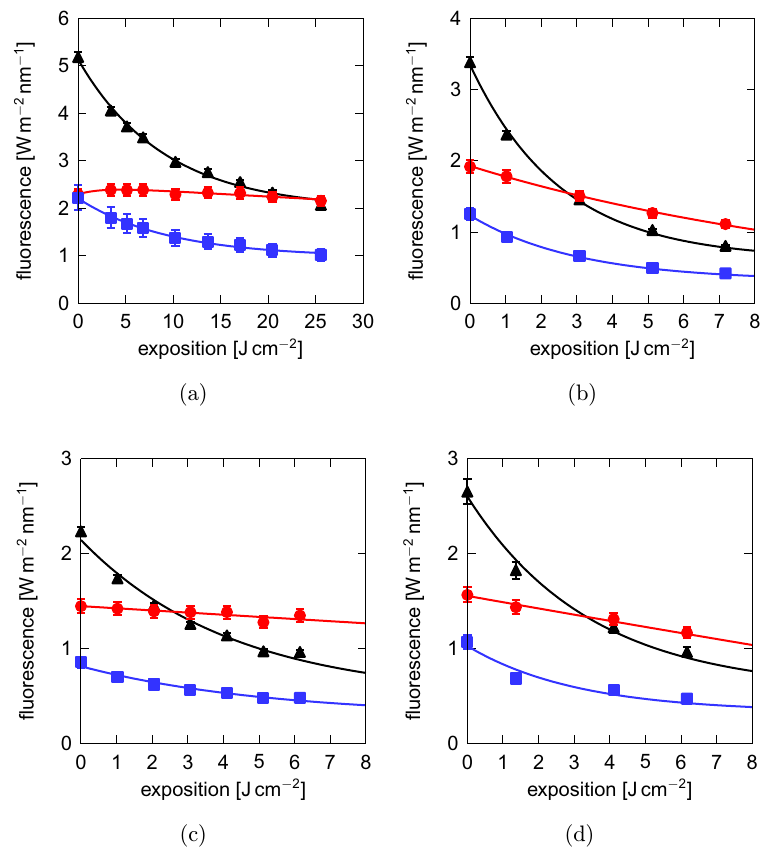
Fig. 6. Typical bleaching curves of the tree main °uorescence bands (635 nm triangles, 675 nm circles and 705 nm squares) in animals treated by MAL (top) and control (bottom) in lesion (left) and out of lesion